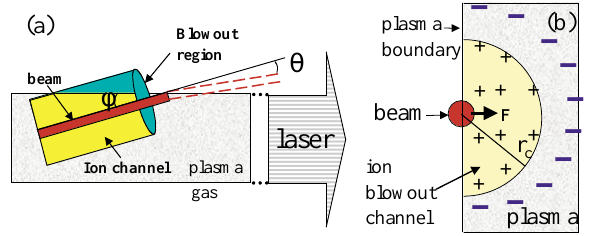
FIG. 1. (Color) Schematic of refraction mechanism. (a) Side view and (b) front view of beam and plasma illustrating how asymmetric blowout creates a net deflection